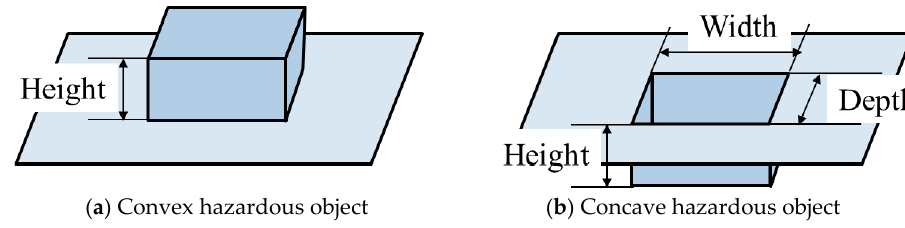
Figure 3. Static hazardous object.